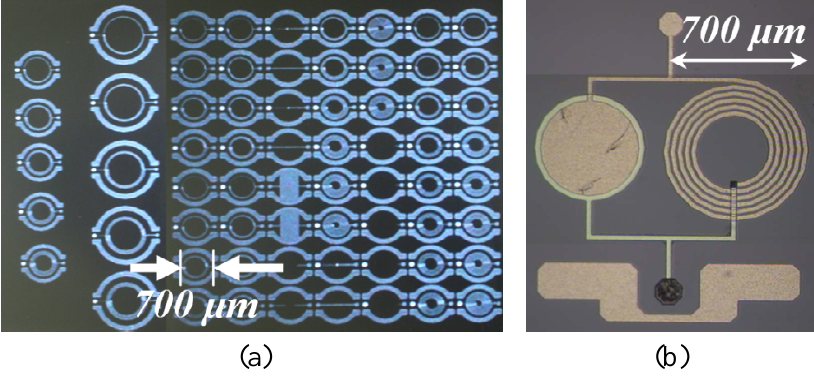
Figure 7. Fabricated (a) inductors and (b) LC- resonator on silicon.